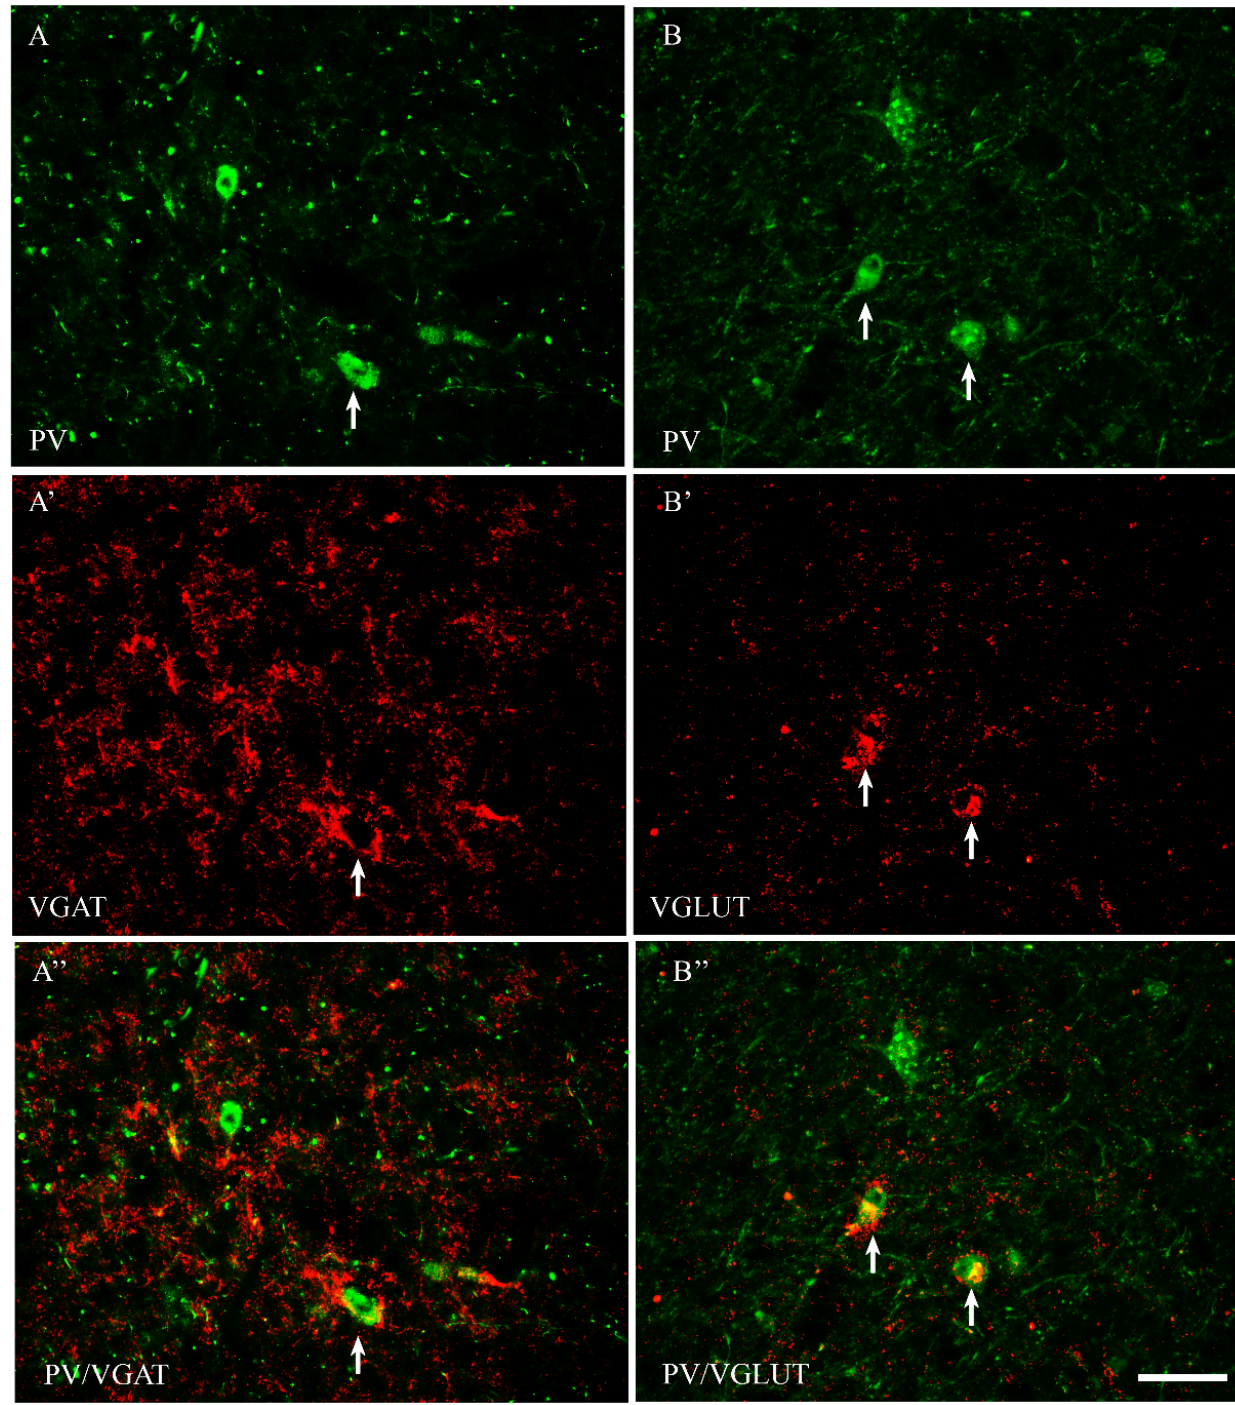
Figure 5. Representative microphotographs demonstrating the anatomical relationships between PV+ neurons and VGAT ( A–A” ) as well as PV+ neurons and VGLUT ( B–B” ) in the medial preoptic area of the guinea pig. Arrows indicate double-labelled cells. Scale bar = 50 μ m.